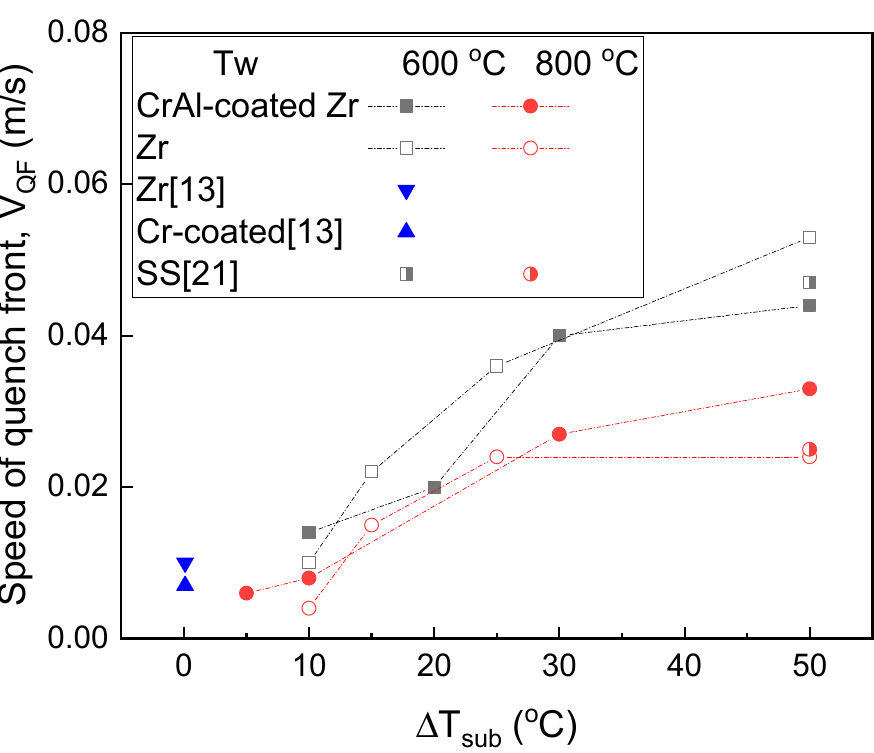
Figure 17. Speed of quench front for Zr and CrAl-coated Zr claddings.